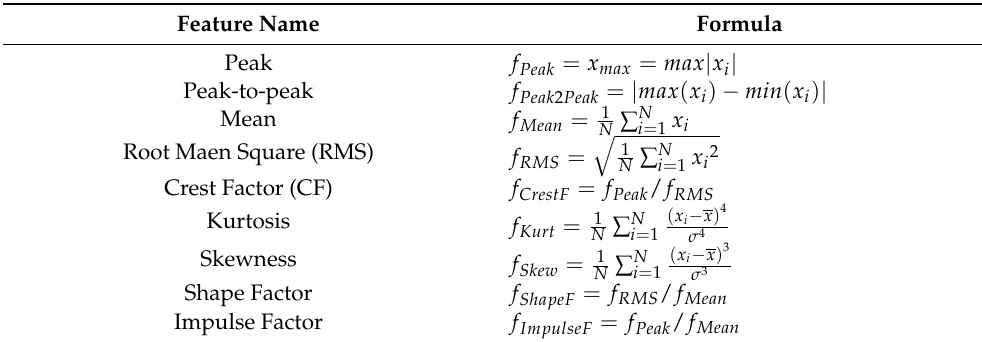
Table A1. Extracted time features from raw signals. x i , is the signal (observation) at the time i , i = 1 . . . S N , S N is the length of the signal segments, x is the mean value of x i , i = 1 . . . S N , and σ 3 σ 4 are third and the fourth moment of x i , i = 1 . . . S N ,